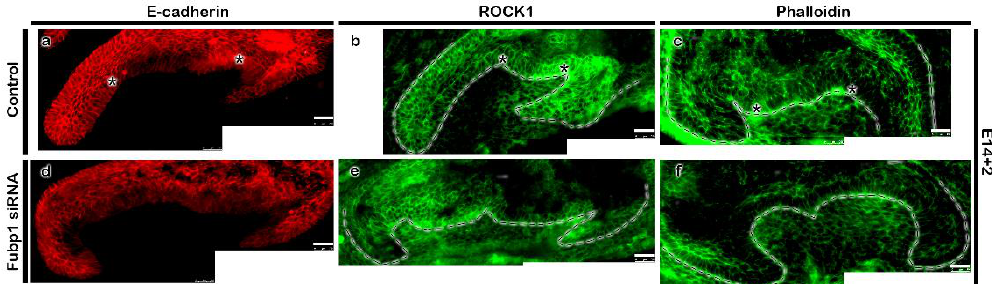
Figure 3. Altered epithelial cell rearrangements in Fubp1 knock-down molar. Knocking down Fubp1 at E14 for 2 days shows decreased localization of E-cadherin and ROCK1 along the inner enamel epithelium ( a – e ). Similarly, weak phalloidin staining is observed in the basement membrane of inner enamel epithelium along the secondary enamel-knot in the Fubp1 knock-down tooth compared with control ( c , f ). The dotted lines demarcate the boundary of tooth epithelium ( a – f ).* in control indicates compared with the same region of Fubp1 knock-down tooth ( a – f ). Scale bars: 20 µ m ( a – f ).